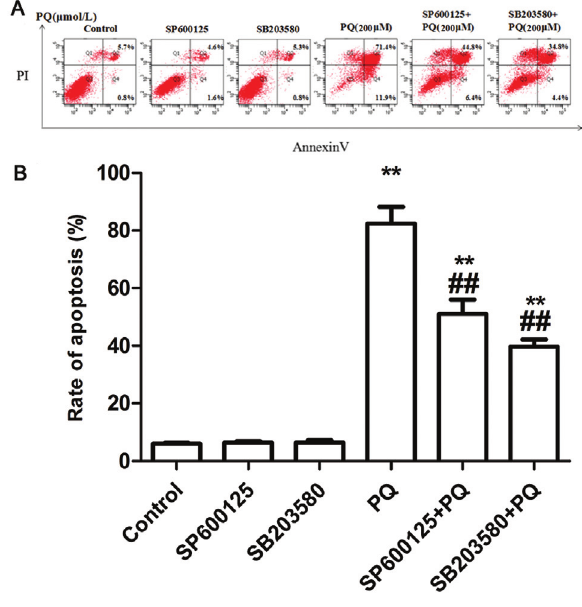
Figure 2 - A: Flow cytometry analysis of apoptotic rates in each group; B: Statistical analysis of apoptotic rates in each group. ** P < 0.01 vs control group; ## P < 0.01 vs PQ alone group.